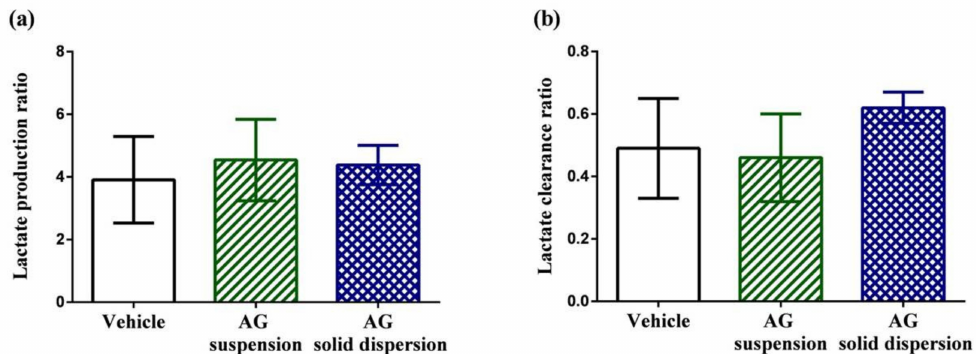
Figure 8. E ff ect of andrographolide (AG) on: ( a ) lactate production ratio; and ( b ) lactate clearance ratio. Data are expressed as mean ± standard deviation ( n = 5 for each group). Lactate production ratio = (Lactate post-swimming − Lactate pre-swimming ) / Lactate pre-swimming . Lactate clearance ratio = (Lactate post-swimming − Lactate 30 min later after post-swimming ) / Lactate post-swimming